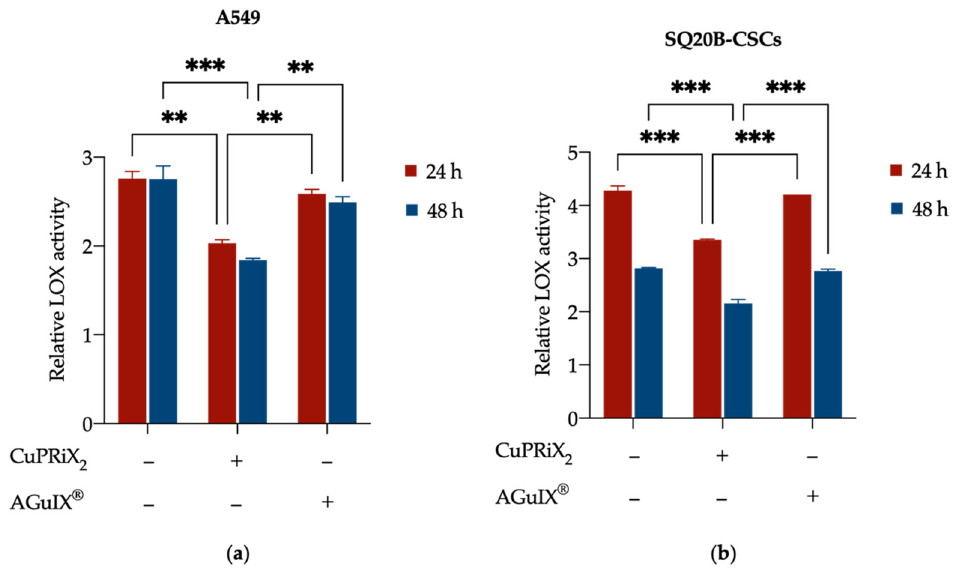
Figure 4. Effect of AGuIX ® (800 µ M of DOTAGA(Gd)) and CuPRiX 2 (800 µ M of DOTAGA(Gd) and 500 µ M of uncomplexed DOTAGA) on LOX activity in ( a ) A549 and ( b ) SQ20B-CSCs cells. Cells were treated for 24 h and 48 h and the activity of LOX (an extracellular copper-dependent enzyme) in the culture medium was assessed. LOX activity levels are relative to background noise (blank control). Data are presented as mean ± SD ( n = 2) with 2 technical replicates for each experiment. ** p < 0.01, *** p < 0.001, two-way ANOVA.